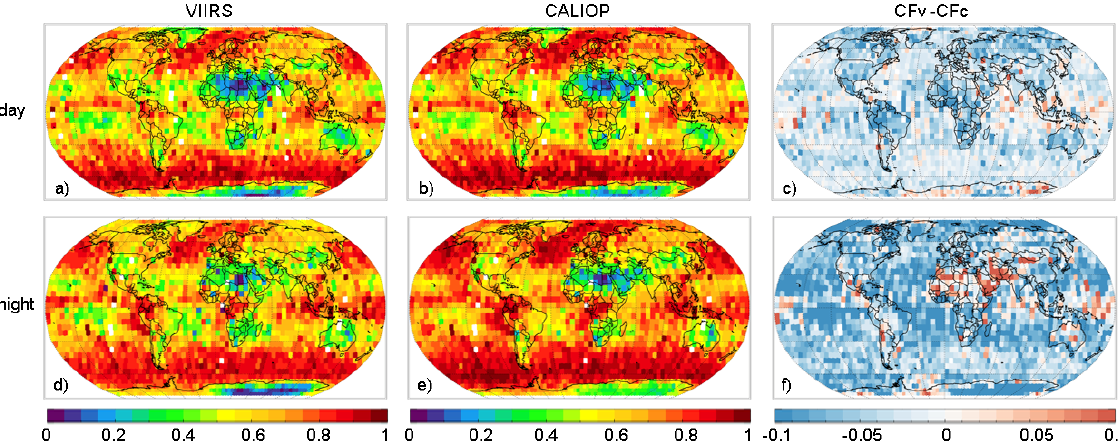
Figure 1. Gridded (5° × 5°) mean daytime ( a – c ) and nighttime ( d – f ) cloud fractions from CV1S ( a , d ) and CALIPSO (HA ≤ 5 km; ( b , e )) and their differences ( c , f ) using all matched data from JAJO 2015–2016.